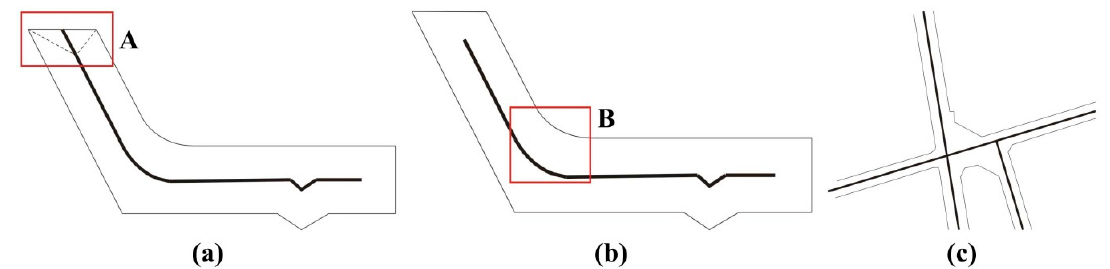
Figure 3. Optimization of straight skeletons in Haunert and Sester [25]: ( a ) topologically constrained correcting algorithm, ( b ) skeleton elimination algorithm and ( c ) connection point reconstruction algorithm.